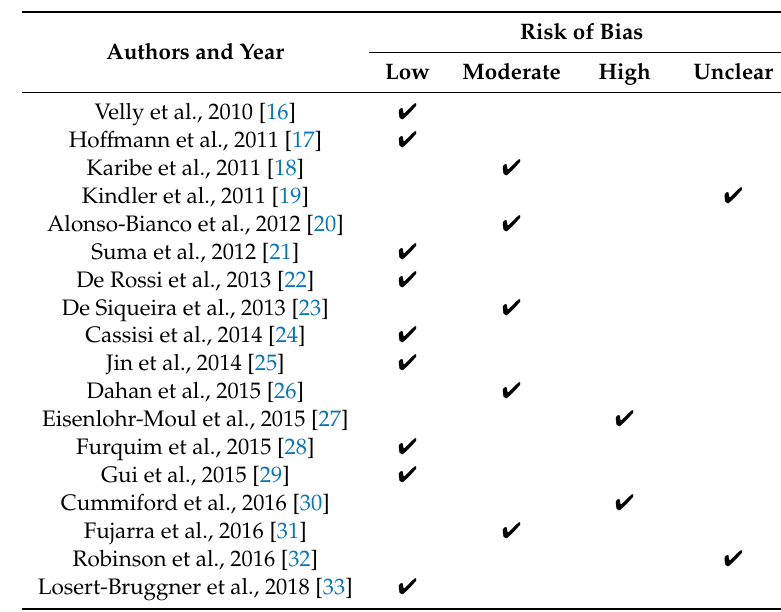
Table 3. Risk of bias results table.